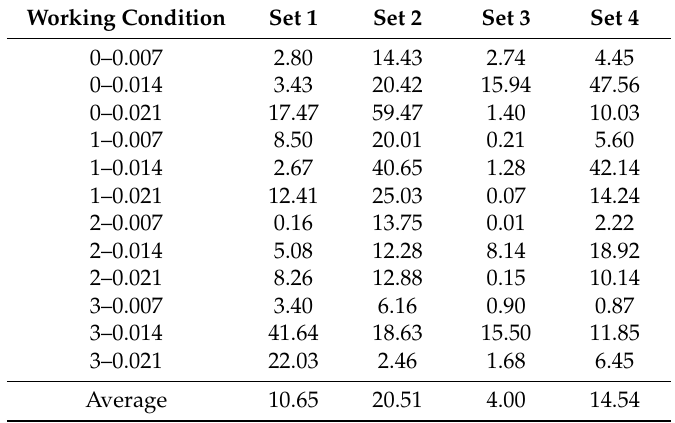
Table 6. Variances of diagnostic accuracy to all independent experiments corresponding to 12 different working conditions respectively with the scheme of (5/95) in 1st–4th experiment